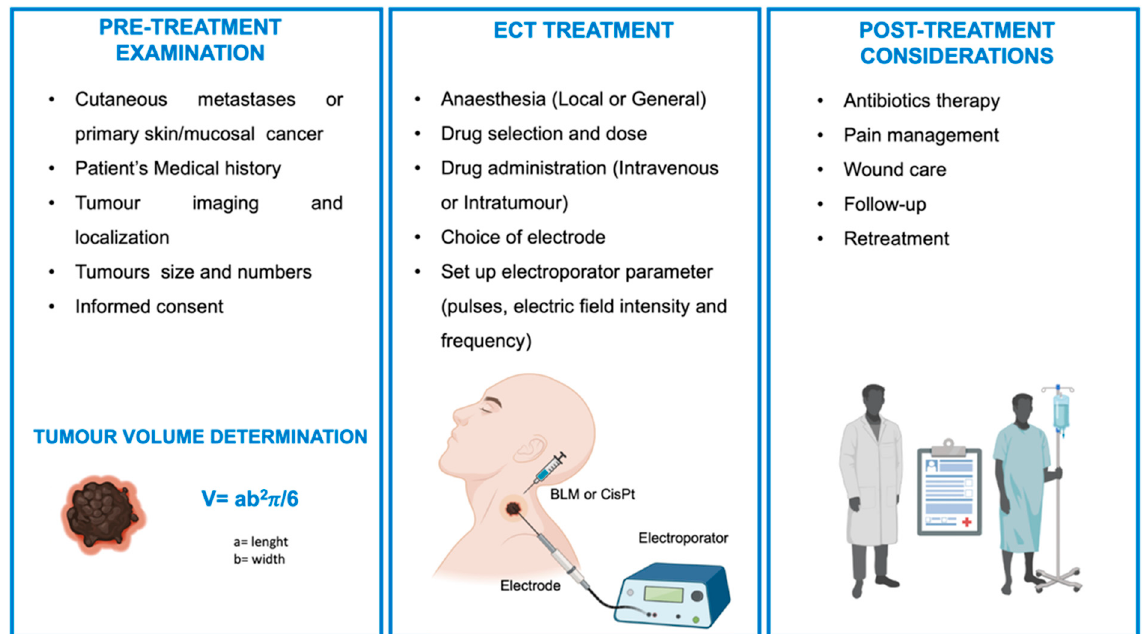
Figure 4. Overview of Standard Operating Procedure (SOP) for Electrochemotherapy (ECT) in the treatment of cutaneous primary and secondary tumors and mucosal cancer (created with BioRender—www.BioRender.com accessed on 28 Octorber 2022).